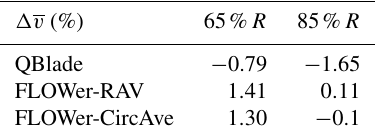
Table 9. Relative differences between the experiment and the differ- ent simulation results of the averaged on-blade velocity with respect to the undisturbed velocity at the probe positions for